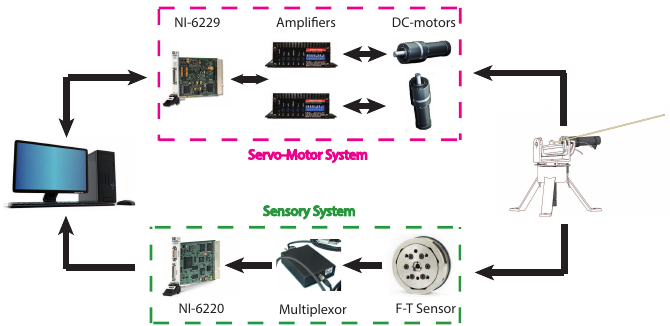
Figure 4. Scheme of the sensing antenna.